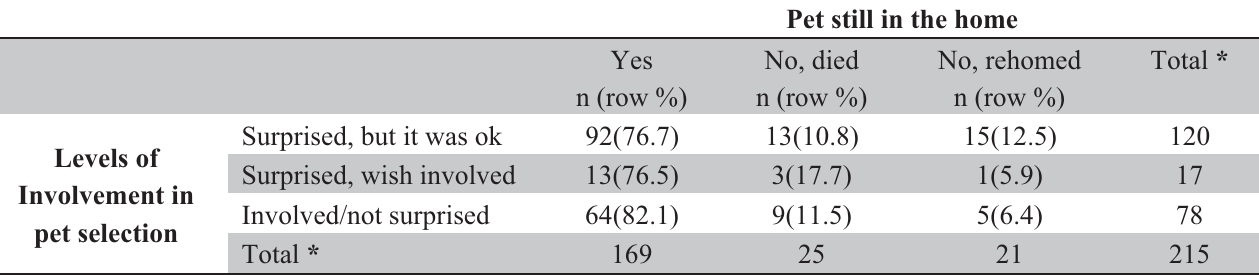
Table 2. Frequencies of the impact receiving a gift has on retention in the home. * Response choices: Refused, Don’t Know and Other are